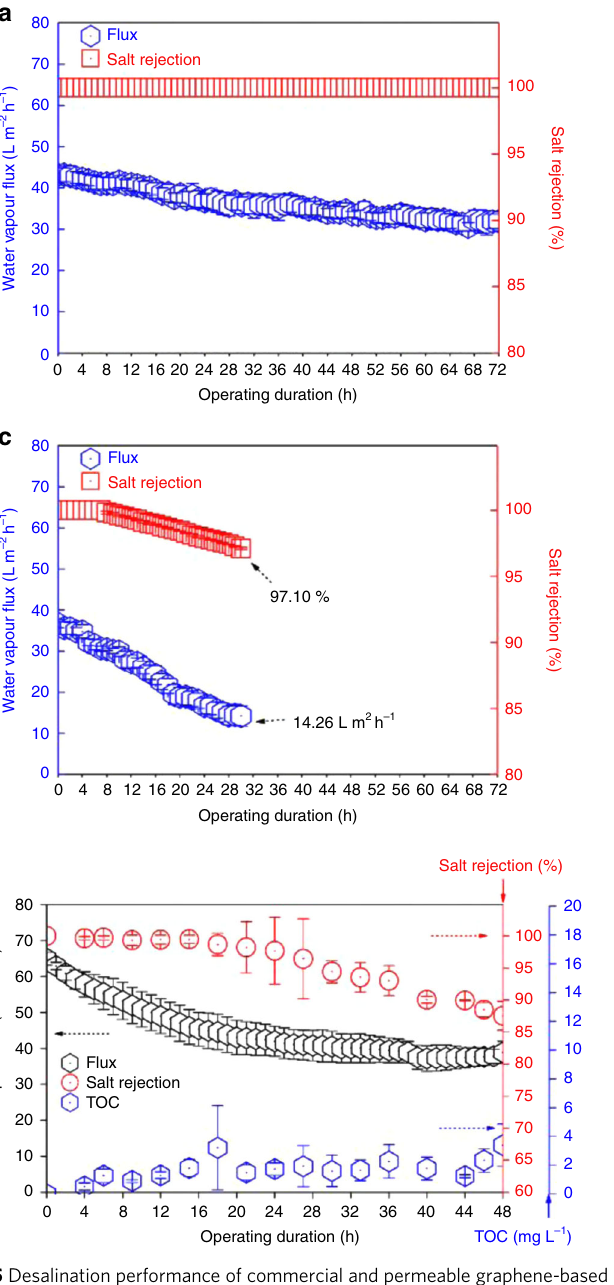
Fig. 5 Desalination performance of commercial and permeable graphene-based MD membranes. Water vapour fl ux and salt rejection performances of the membranes: a commercial PTFE-based MD membrane and b permeable graphene-based membrane in the DCMD process for 72 h, with 70 g L − 1 of NaCl solution as feed. c Commercial PTFE-based MD membrane and d permeable graphene-based membrane with 70 g L − 1 NaCl solution and 1 mM sodium dodecyl sulphate (SDS) as feed. The fl ow rates of these DCMD tests were both maintained at 6 L h − 1 in the feed and permeate stream. e Commercial PTFE- based MD membrane and f permeable graphene-based membrane in the DCMD process with a feed solution containing 1 g L − 1 mineral oil with 70 g L − 1 of NaCl and 1 mM NaHCO 3 in the DCMD process for 48 h. The feed and permeate temperatures were 60 and 20 °C, respectively. The fl ow rates of these DCMD tests were both maintained at 30 L h − 1 in the feed and permeate stream. The error bar represented SD from three repeated fi ltration tests. Our results demonstrate that the permeable CVD graphene-based membranes exhibit strong antifouling properties while enabling rapid water vapour permeation and good salt